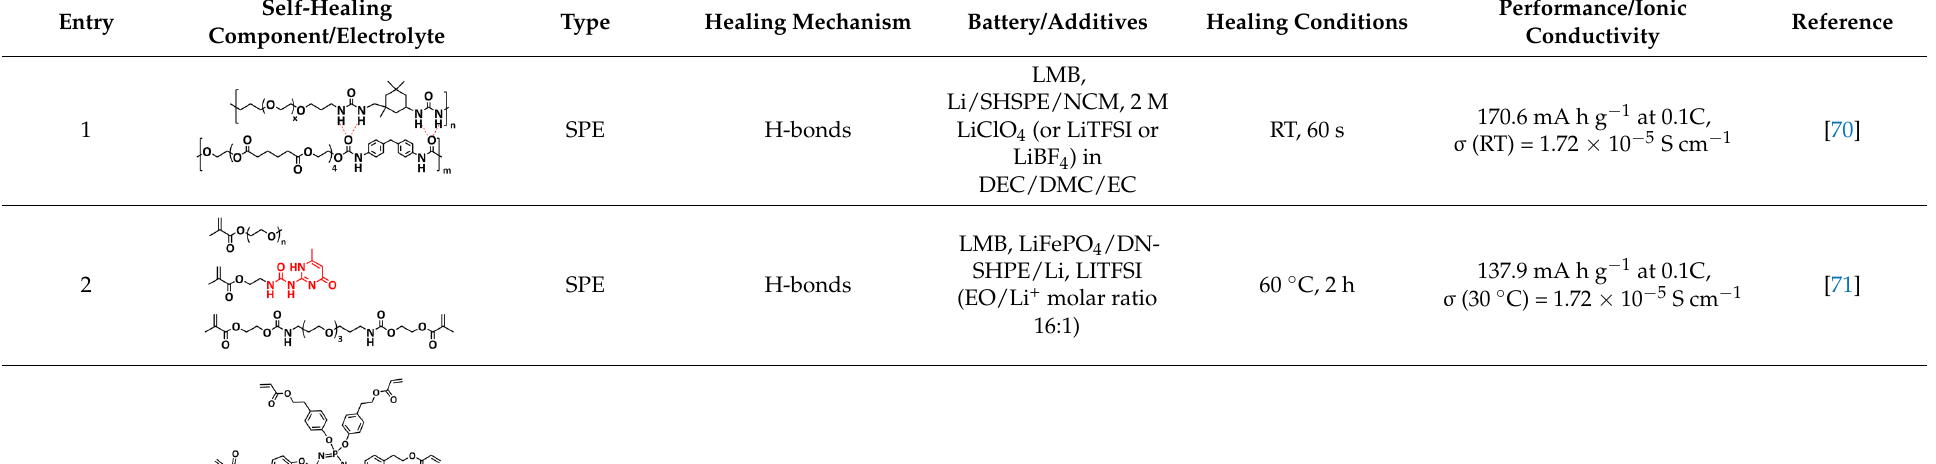
Table 1. Various self-healing polymers evaluated as electrolytes in lithium batteries.